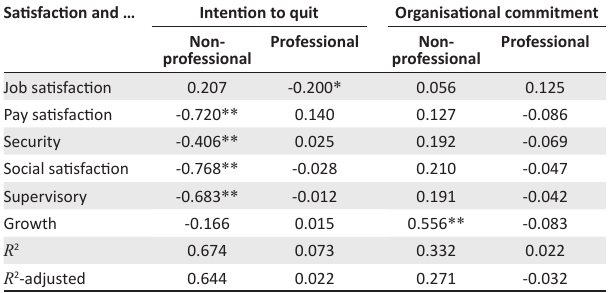
TABLE 3: Correlation between satisfaction and intention to quit and organisational commitment per staff status.